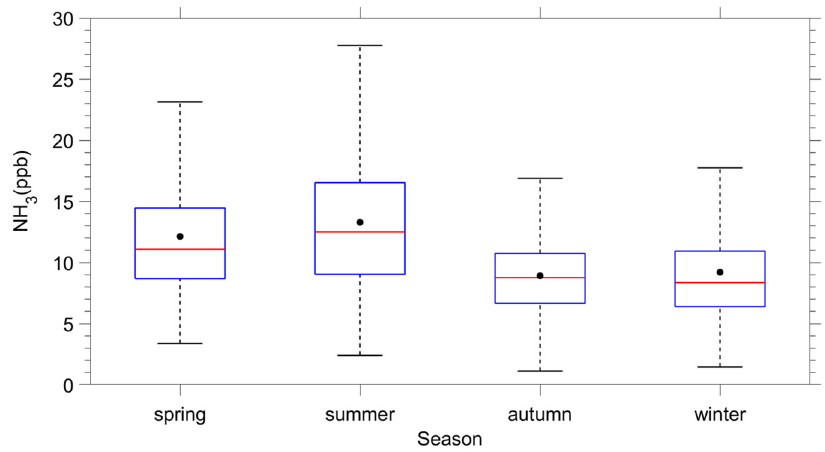
Figure 3. Seasonal NH 3 concentrations at the monitoring site. Box lines represent the 75th quartile and the 25th quartile, and whiskers represent the minimum and maximum concentration values, excluding outliers. The black dot indicates average concentration of NH 3 for each season, and the red line indicates median concentration.